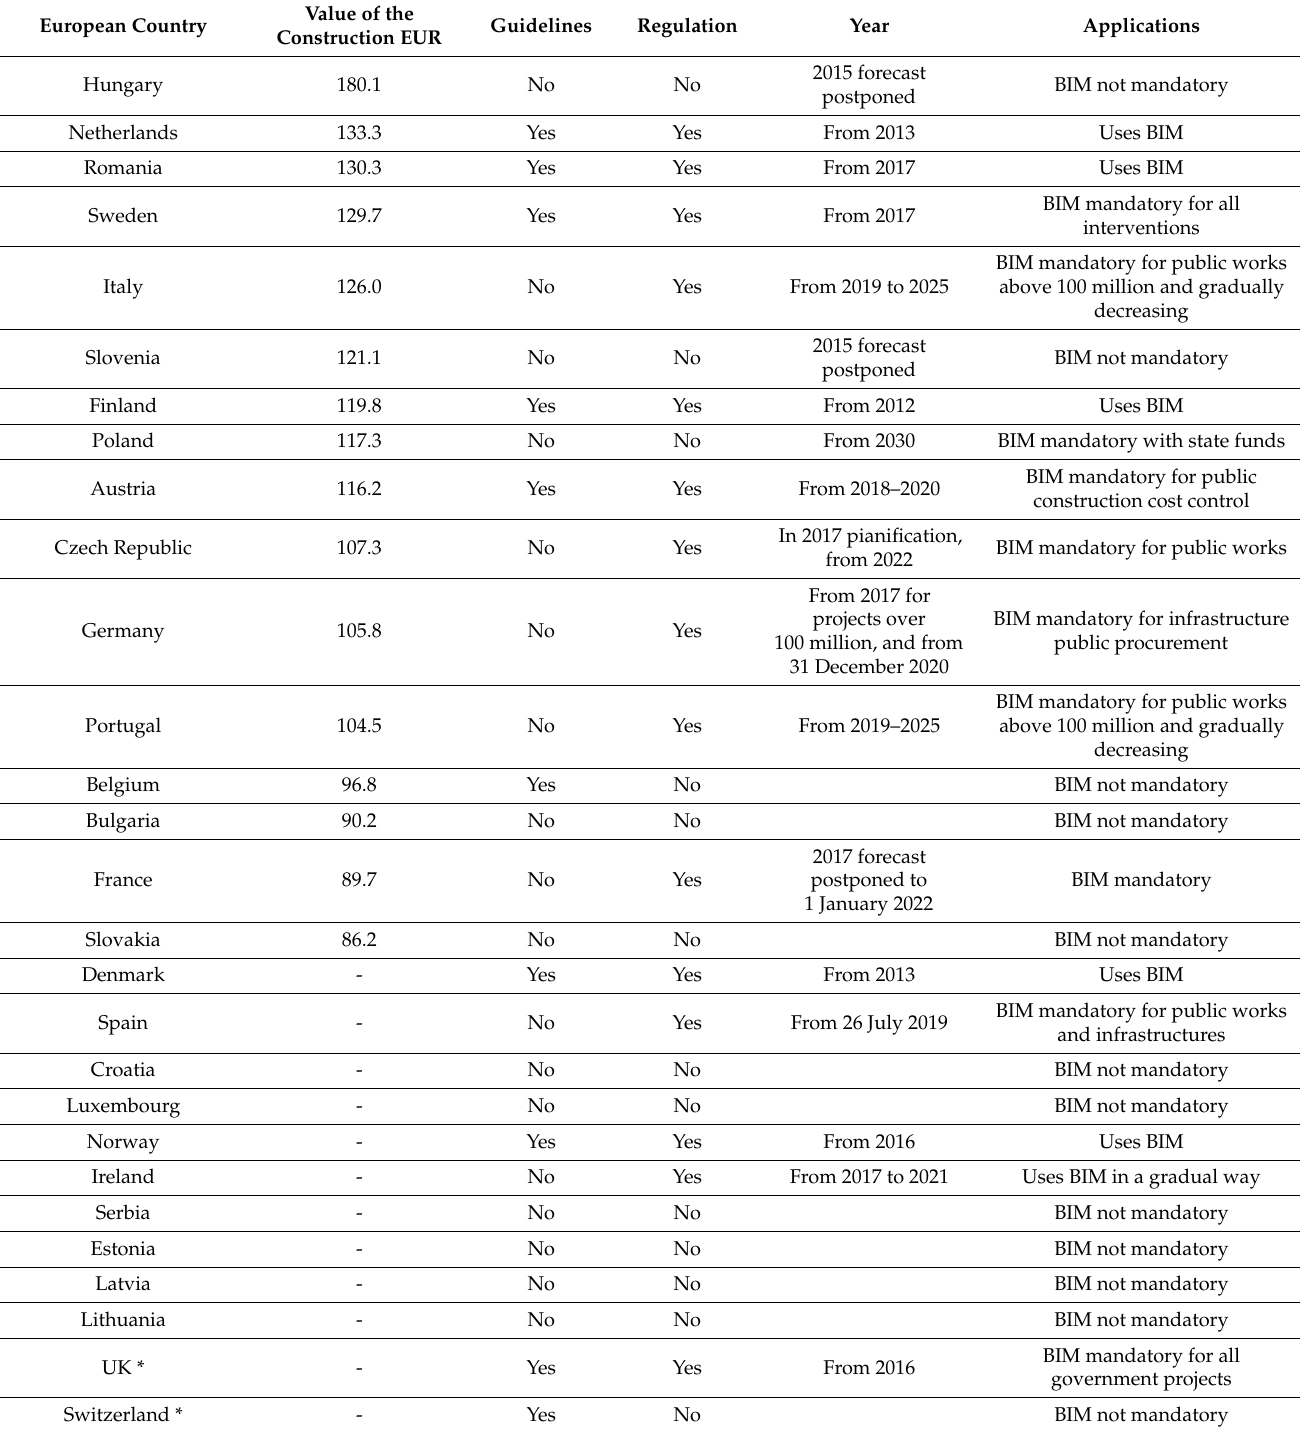
Table 2. Situation in Europe updated to